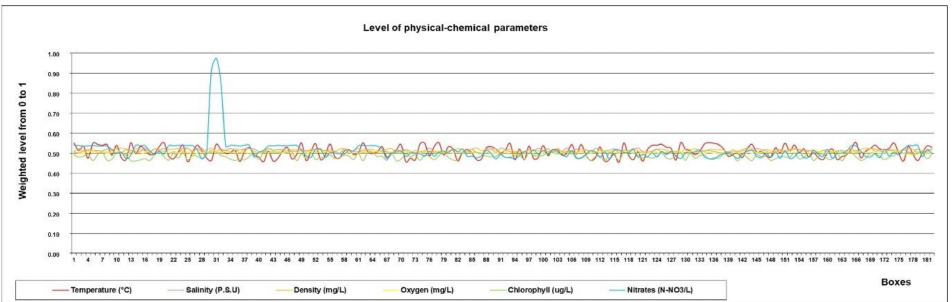
Figure 7. Normalized sensor values used for the